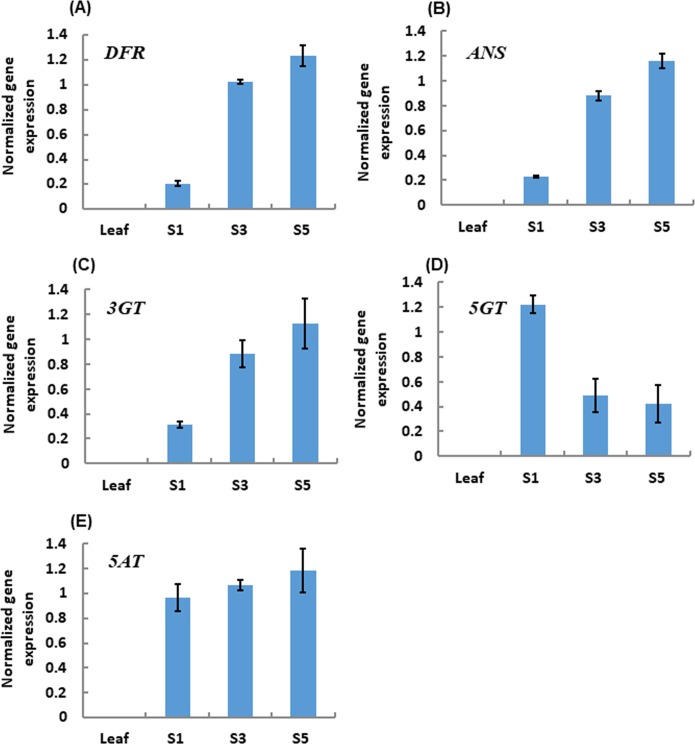
Quantitative expression of anthocyanin genes, normalized on the ubiquitin housekeeping gene in leaf and petals of Gentiana lutea L. var. aurantiaca.qRT-PCT data were calculated from three biological replicates with at least three technical replicates for each biological replicate and with error bars representing the standard deviation. Abbreviations: 5AT, anthocyanin 5-aromatic acyltransferase gene; ANS, anthocyanidin synthase gene; DFR, dihydroflavonol 4-reductase gene; 3GT, UDP-glucose:flavonoid 3-O-glucosyltransferase gene; 5GT, UDP-glucose:flavonoid 5-O-glucosyltransferase gene.